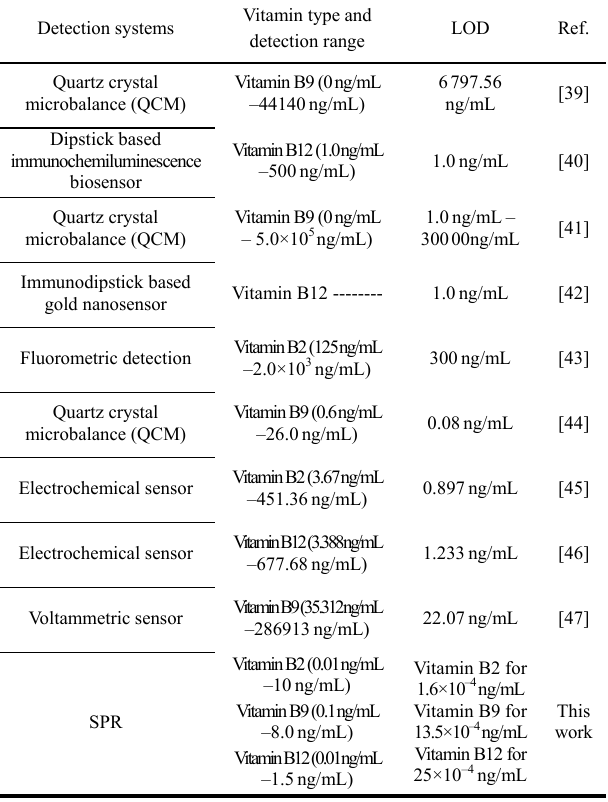
Table 2 Comparison of vitamins B2, B9, and B12 detection methods.